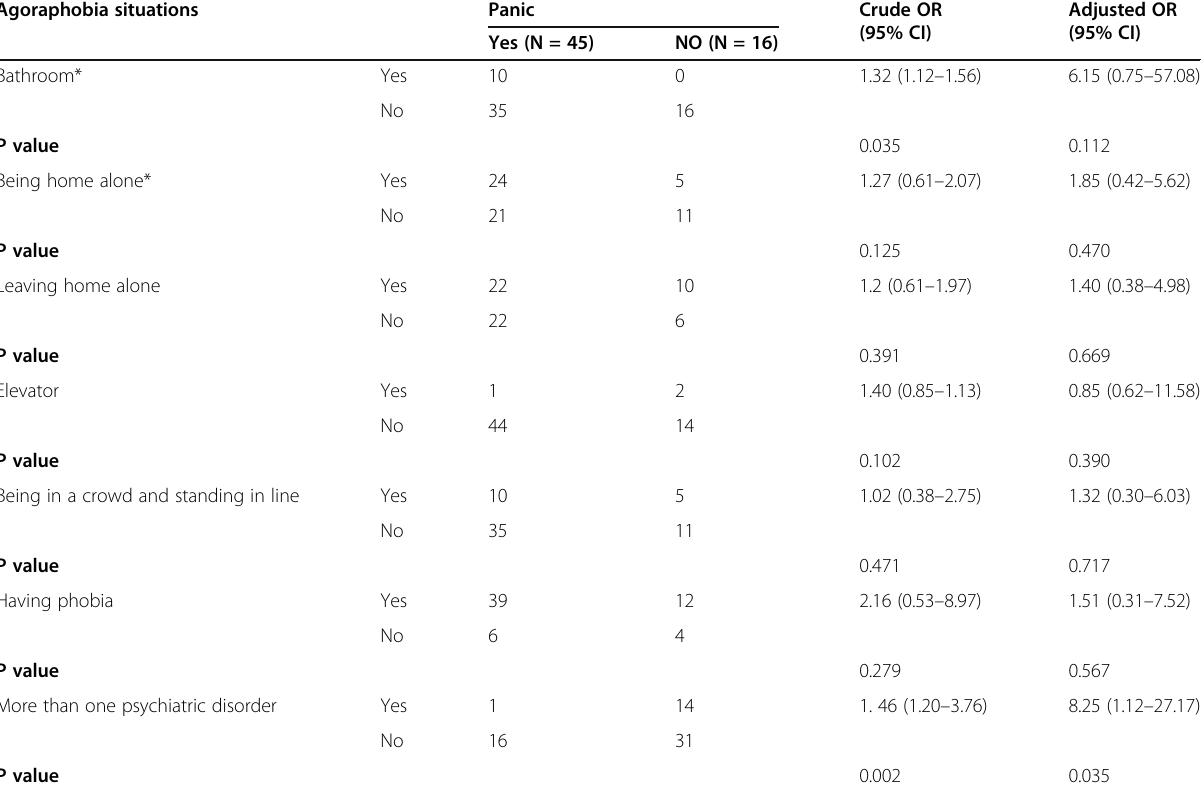
Table 4 Measure of association between various types of agoraphobia situations and panic disorder by multiple logistic regression Agoraphobia